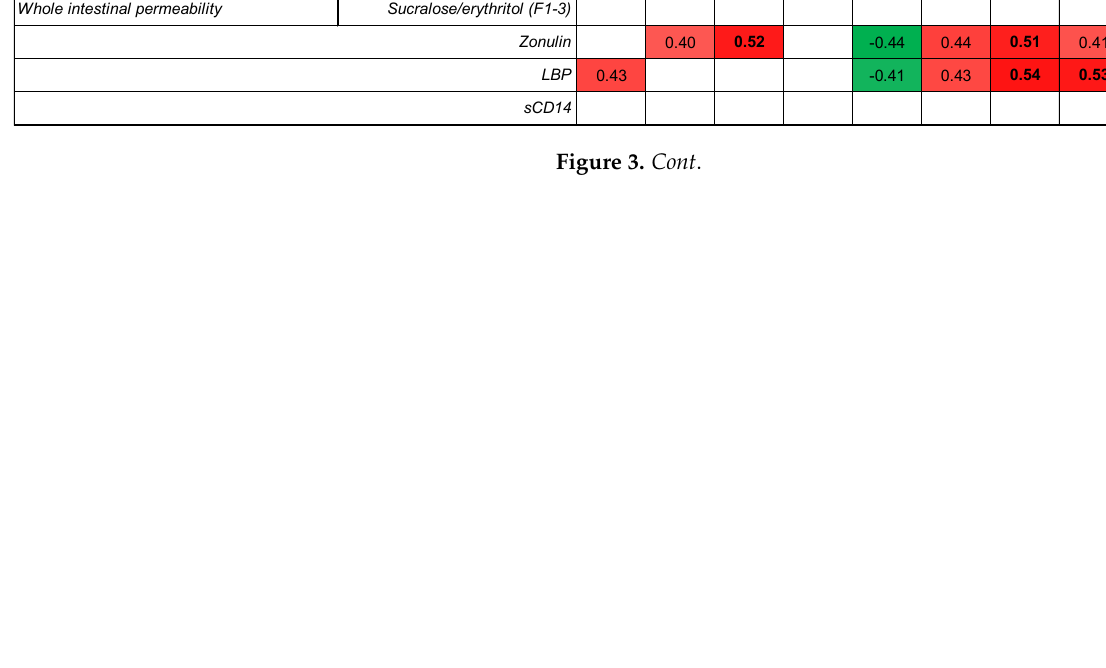
Figure 3. Correlation between metabolic health and gut permeability markers. Pearson’s correlation was performed on the log 10 -transformed values of metabolic health markers and sugar ratios and LGM ( A ) without an acetylsalicylic acid challenge (unchallenged) and ( B ) with an acetylsalicylic acid challenge. Nonbold: correlation is significant at the 0.05 level (2-tailed), bold: correlation is significant at the 0.01 level (2-tailed), and empty cells: no significant correlation. Red indicates a positive correlation (more intense color means a higher correlation), and green indicates a negative correlation. 4. Discussion This study was conducted to investigate whether metabolic health could be linked to intestinal permeability, as assessed by an MS permeability test that provides site-specific information on paracellular permeability along the gastrointestinal tract. Therefore, we intended to select clearly distinctive metabolically healthy and metabolically unhealthy subjects. However, although the average BMI, fasting glucose level, and triglycerides level in the metabolically unhealthy group were significantly higher than those in the metabol- ically healthy group, all these subjects were still in the normal, healthy range according to the IDF global definition of metabolic syndrome [21]. This indicates that these subjects had a slightly elevated risk but not as extreme as is often seen in such studies comparing healthy individuals with diseased individuals [17,22,23]. In the unchallenged MS permeability test, no significant differences in the sugar ra- tios were found between the metabolically healthy and unhealthy subjects. This is in ac- cordance with a study by Farhadi et al. [17], who found that, without an acetylsalicylic challenge, the gut permeability was not significantly different between metabolically healthy and unhealthy subjects. However, in contrast to the findings of Farhadi et al., in our study, the acetylsalicylic challenge prior to the MS permeability test did not induce substantial differences in gut permeability between metabolically healthy and unhealthy subjects. This may be explained by the fact that Farhadi et al. included patients with stea- tosis and NASH, i.e., those with a more pronounced disease load and high susceptibility